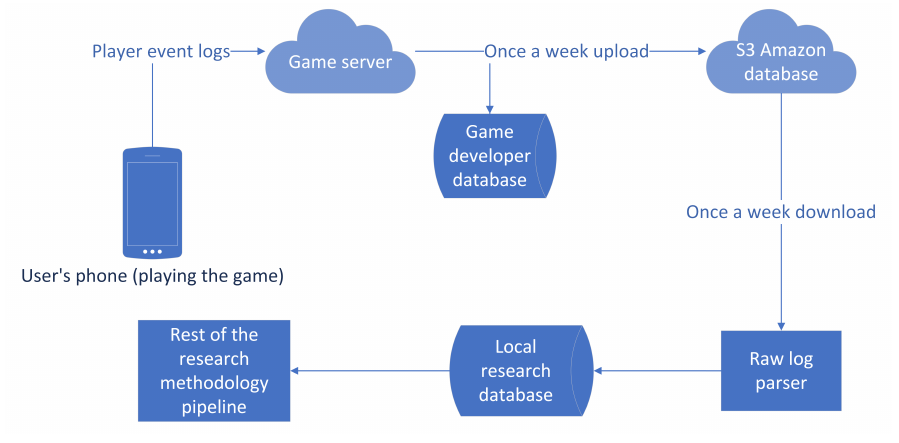
Figure 7. Data pipeline